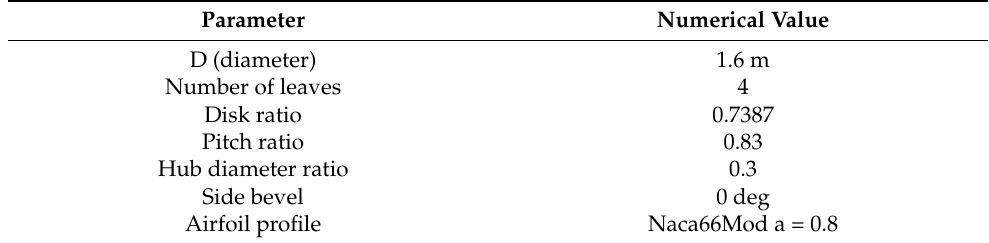
Table 2. Main parameters of propeller.